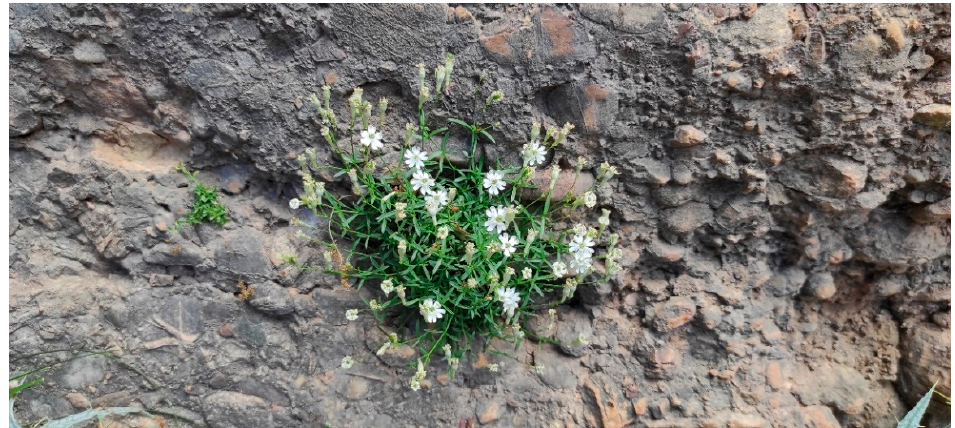
Figure 5. Silene conglomeratica Melzh., a local endemic taxon of the Vouraikos river gorge. 3.1.5. Distribution of the CVNP’s Greek Endemics in the Floristic Regions of Greece